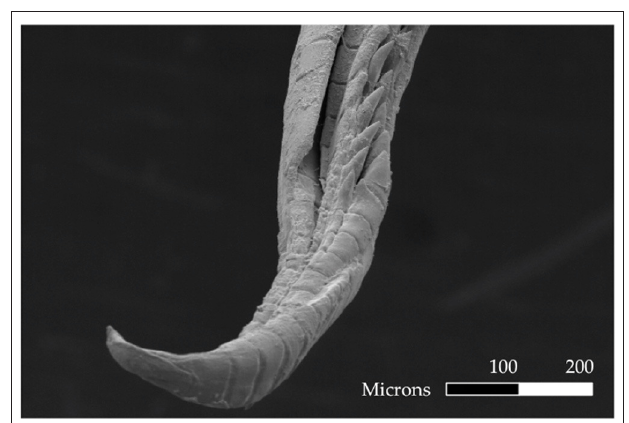
FIGURE 1 | Electron micrograph of a male gonopodium with a sinistral orientation. Scale bar is 100